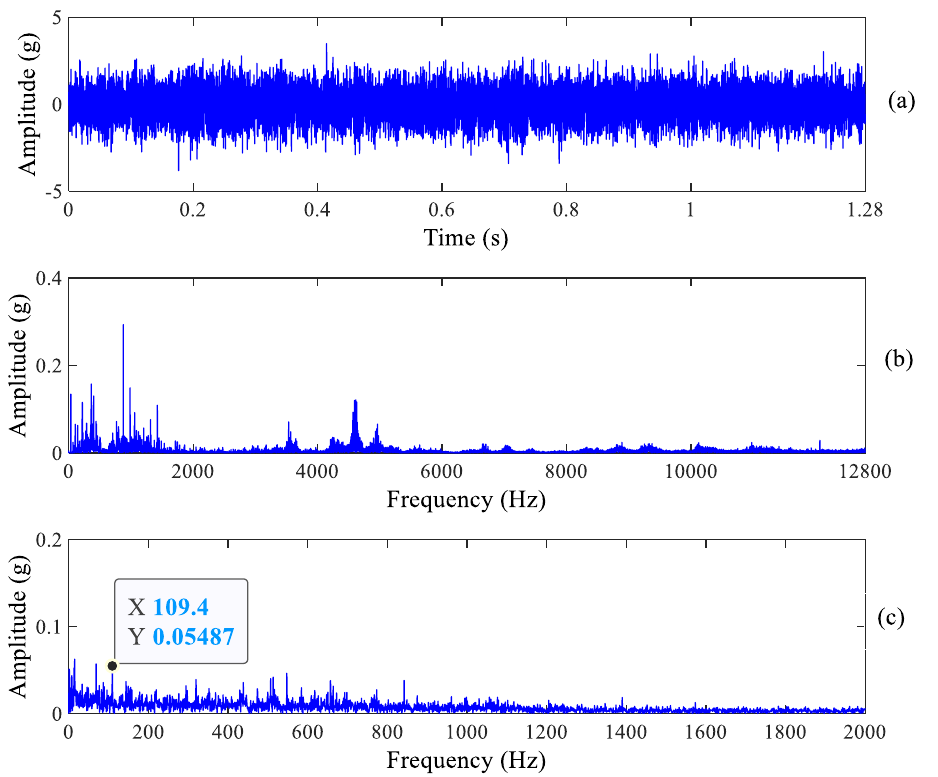
Figure 6. Vertical raw vibration signal and its spectrum: ( a ) Raw signal, ( b ) Frequency spectrum and ( c ) Zoomed envelope spectrum.